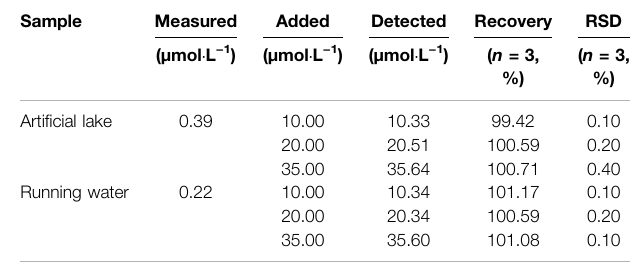
TABLE 1 | Detailed data for CN − detection in real water samples. Sample